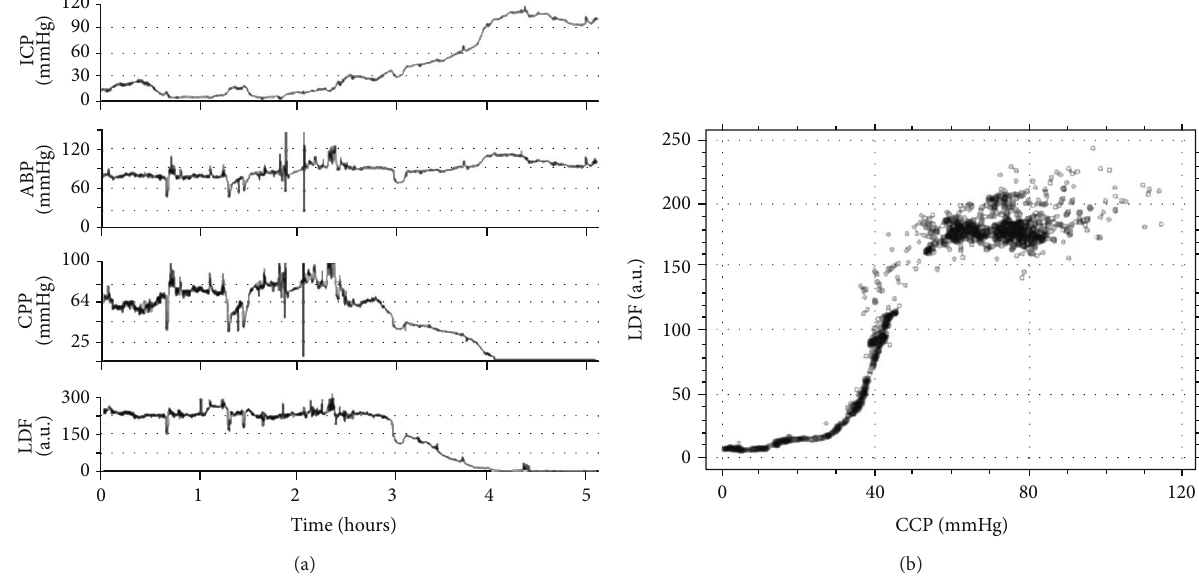
Figure 3: (a) Cortical cerebral blood flow (CBF) can be monitored with laser Doppler flowmetry, and CBF plotted against CPP shows the autoregulatory curve, called Lassen’s curve, with clear lower limit of autoregulation (LLA). ICP: intracranial pressure. ABP: arterial blood pressure. CPP: cerebral perfusion pressure. LDF: laser Doppler flowmetry. (b) Lassen’s curve. CPP: cerebral perfusion pressure. LDF: laser Doppler flowmetry.